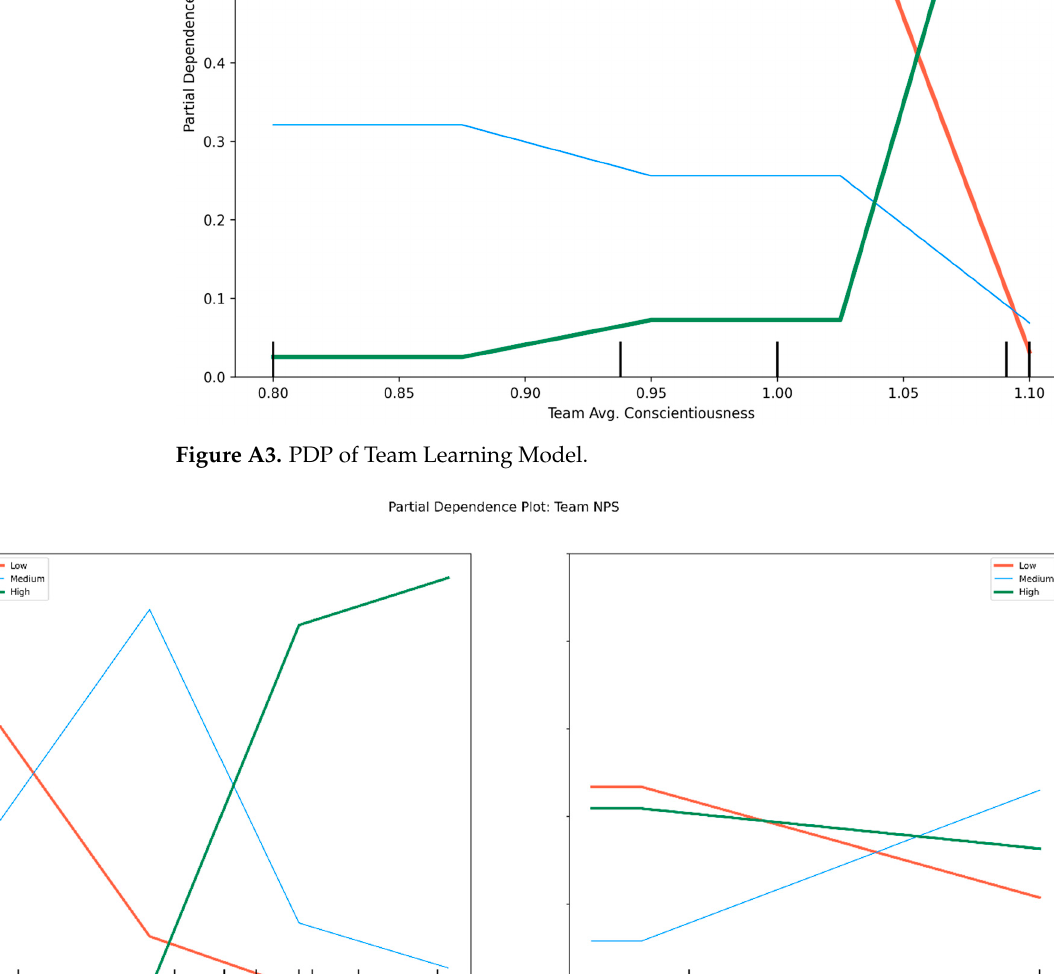
Figure A4. PDP of Team NPS Model.